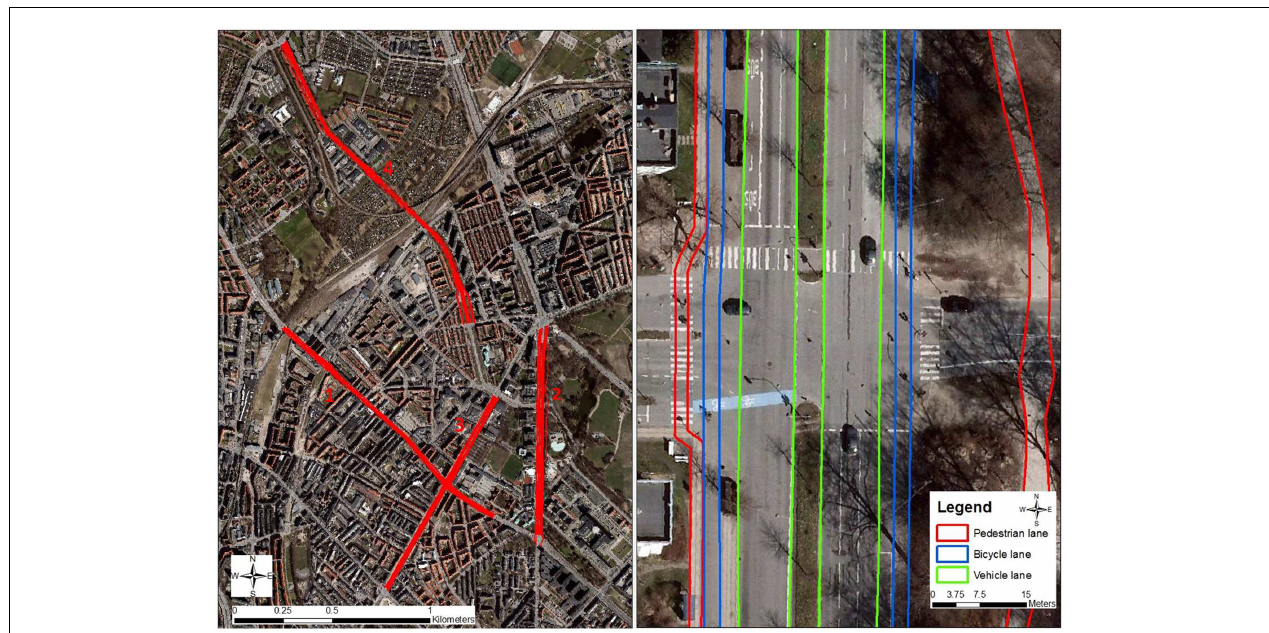
FIGURE 1 | Location of the four study routes (left) and example of the detailed digitization of vehicle, bicycle, and pedestrian lanes (right) .